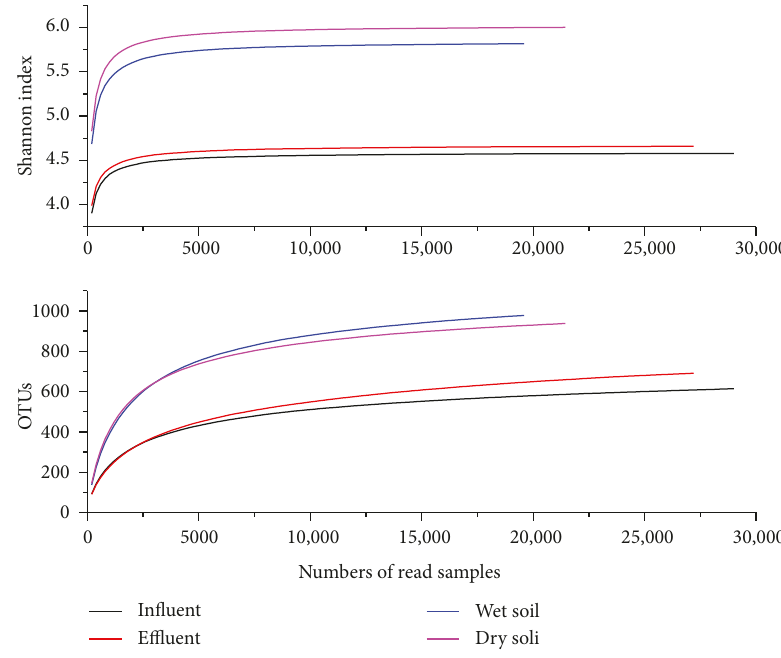
Figure 5: Archaeal rarefaction curves and Shannon diversity index curves. Table 4: Archaeal alpha diversity indices of four samples. Samples Reads